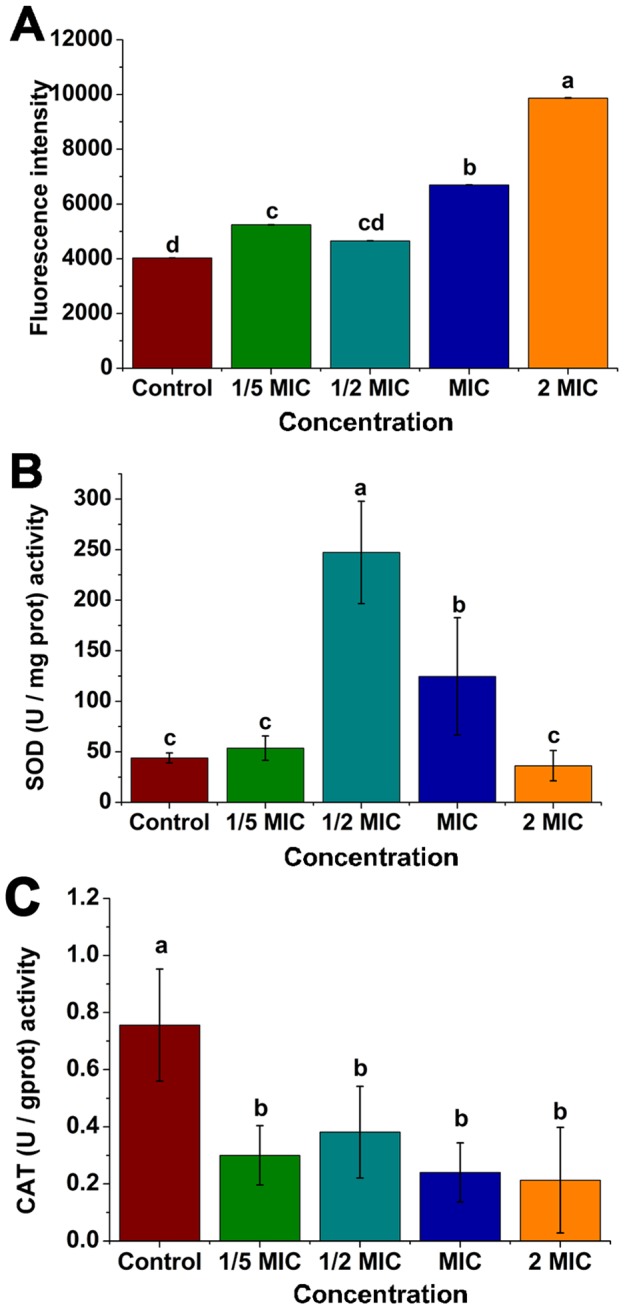
Measurement of reactive oxygen species (A), superoxide dismutase (B) and catalase (C).Cells without Fractionation three treatment were used as the control. Different letters indicated a significant difference (P<0.05; ANOVA and Duncan’s multiple range test). Bars represent the mean ± standard deviation. Each experiment was replicated three times. MIC, Minimum inhibitory concentration; ROS, reactive oxygen species; SOD, superoxide dismutase; CAT, catalase.